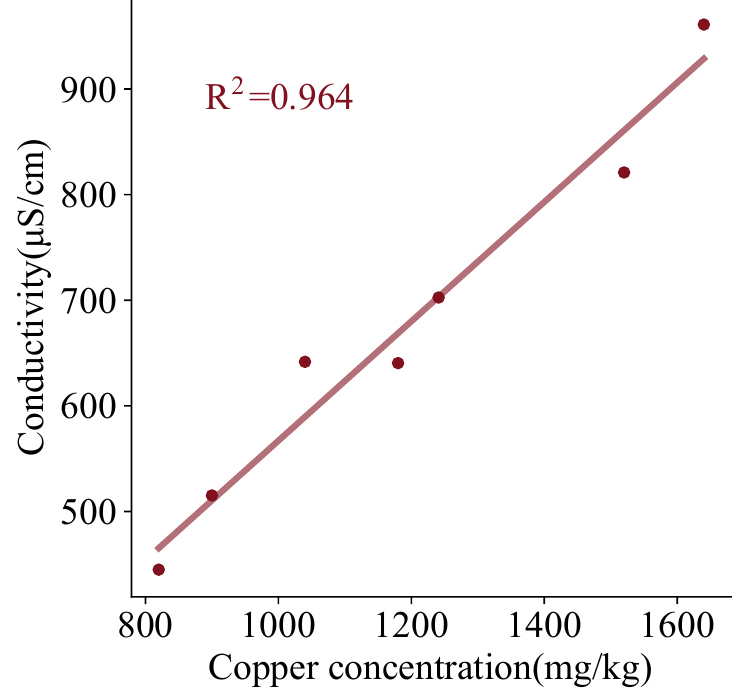
Figure 14. Relationship between conductivity and copper